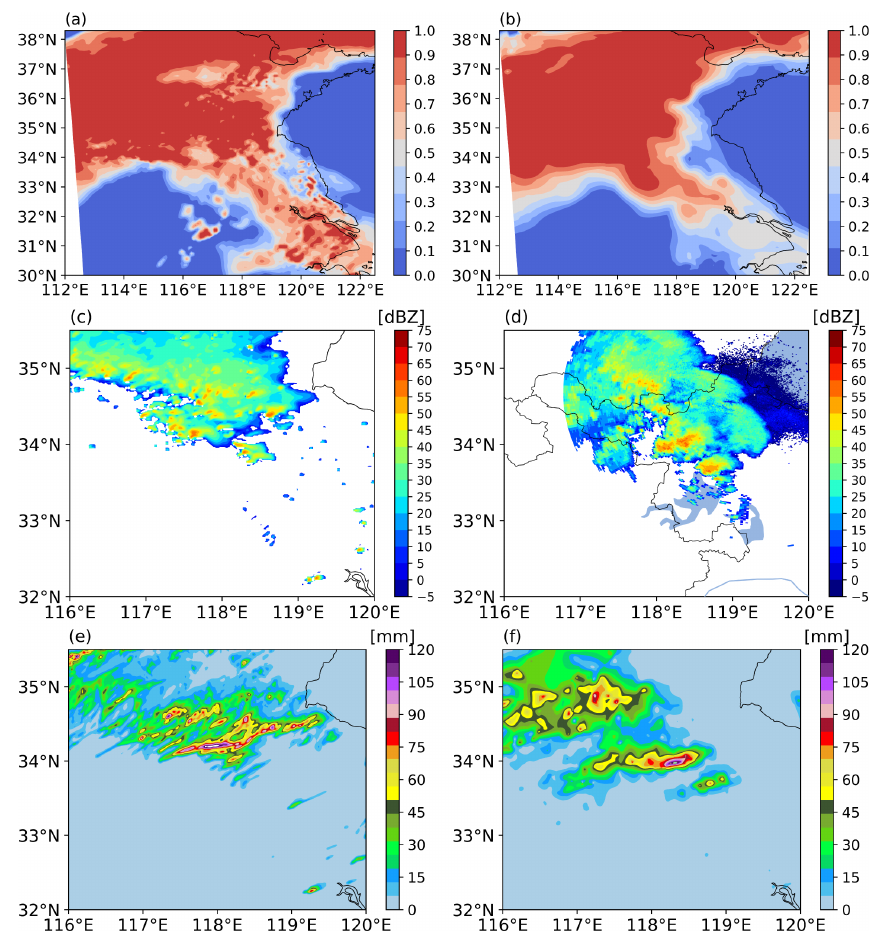
Figure 11. Comparison between the WRF model results and observation data for the convective case. (a) Fraction of cloud cover from the WRF model; (b) fraction of cloud cover from the ERA5 data; (c) radar reflectivity from the WRF model at 04:00UTC; (d) radar reflectivity observed by the Lianyungang radar at 04:02UTC, 23 June; (e) WRF-model-simulated 6h accumulated rainfall from 00:00 to 06:00UTC, 23 June; and (f) 6h accumulated rainfall from rain gauge data from 00:00 to 06:00UTC, 23 June